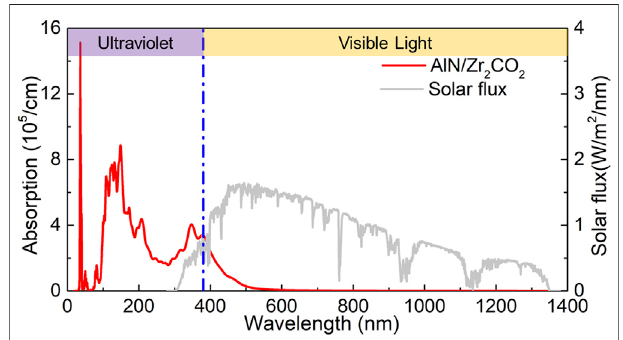
FIGURE 5 | The light absorption spectrum of the AlN/Zr 2 CO 2 vdW heterostructure.